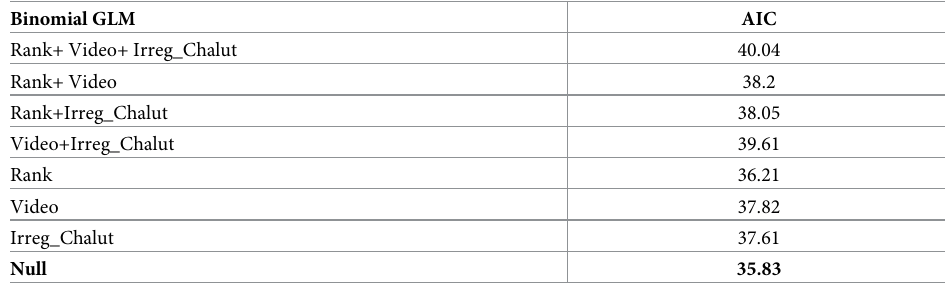
The effect of the two covariates: Rank of the escape attempt and timing of the video footage (video 1 or 2) were tested on the probability of escape using a binomial GLM, resulting in 4 model configurations. AIC estimates used for model selection are given with the AIC criterion for the selected model given in